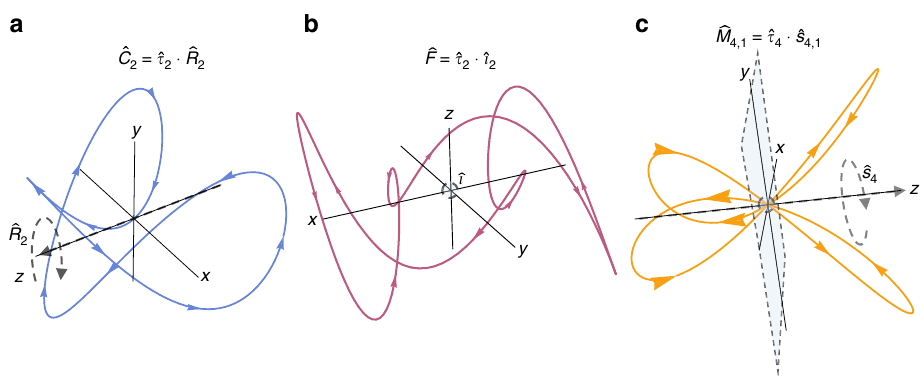
Fig. 5 Example time-periodic fi elds exhibiting (3 + 1)D DSs. a ^ C 2 symmetry for the example fi eld E ( t ) = sin(3 ω t ) ^ x + cos( ω t ) ^ y + cos(2 ω t ) ^ z , ( b ) ^ F symmetry for the example fi eld E ( t ) = cos( ω t ) ^ x + sin(3 ω t ) ^ y + sin(5 ω t + π /6) ^ z , and ( c ) ^ M 4 ; 1 symmetry for the example fi eld E ( t ) = (cos( ω t ) + cos(3 ω t )) ^ x + (sin( ω t ) − sin (3 ω t )) ^ y + cos(2 ω t ) ^ z . The fi elds are represented on 3D Lissajou plots. The spatial parts of the operators are indicated by dashed arrows and planes, colored arrows in the plots indicate the direction